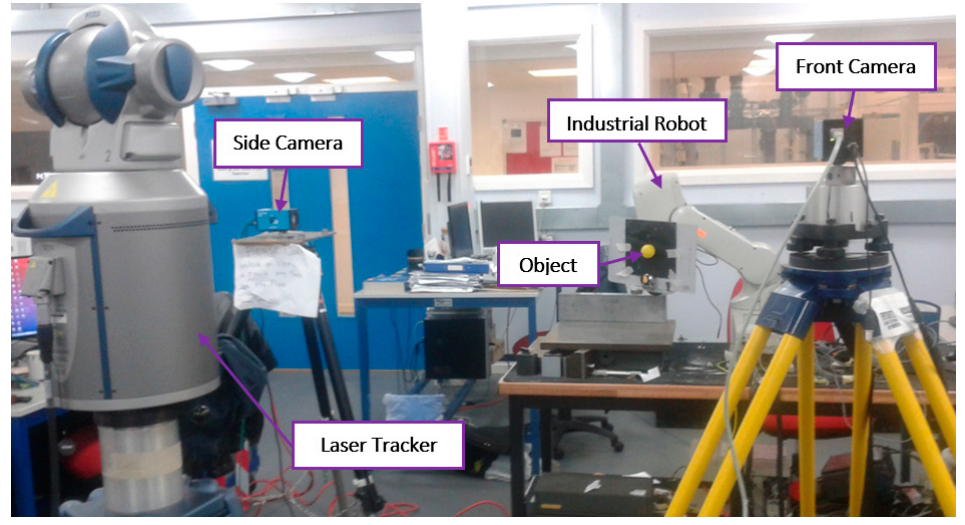
Figure 17. Experiment setup layout.